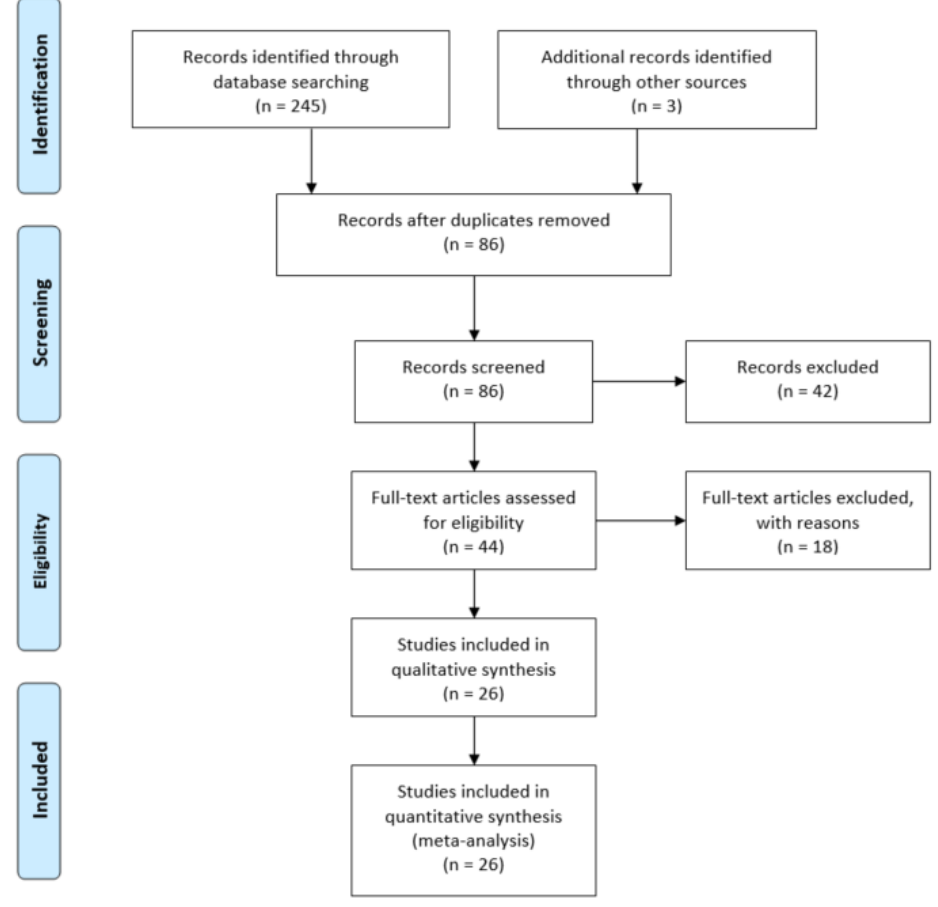
Figure 2. PRISMA flow diagram [37].